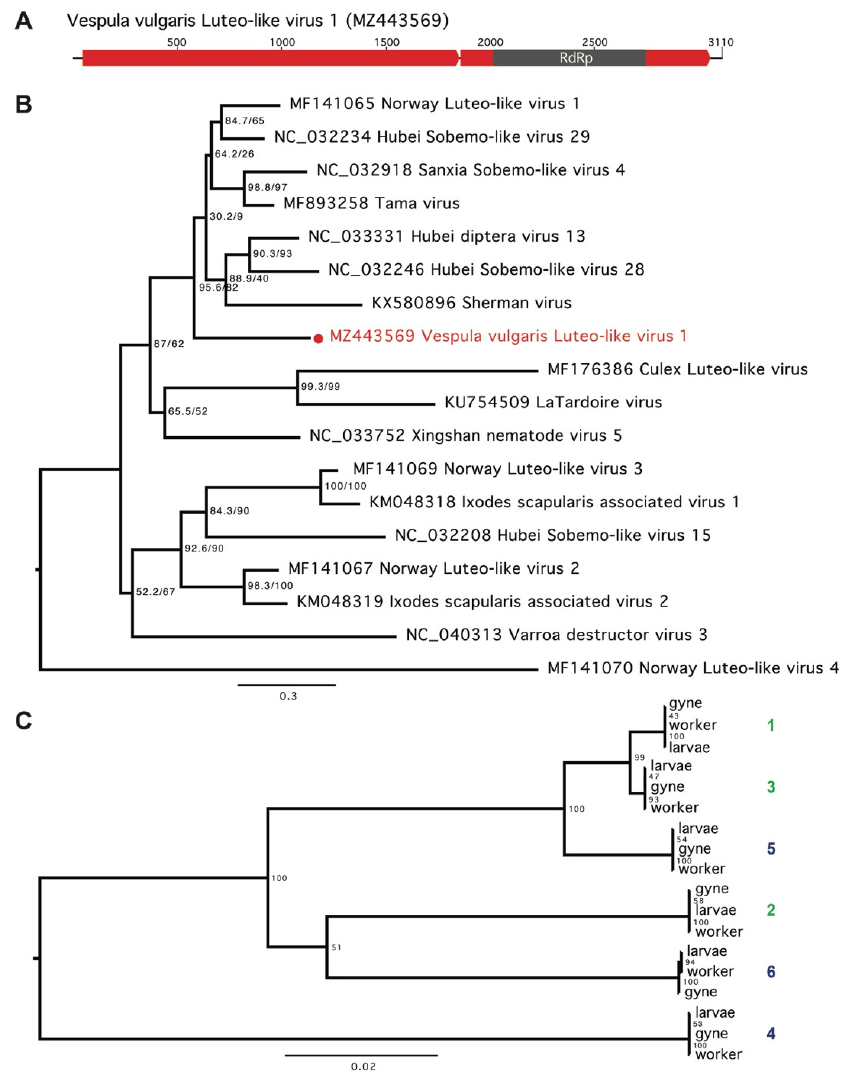
Figure 3. Vespula vulgaris Luteo-like virus 1. ( A ) The 3110-nucleotide genome contains two predicted ORFs (red). Conserved functional domains are indicated in grey. ( B ) Maximum likelihood phylogenetic tree of 18 selected Luteo/Sobemo viruses (GenBank accession numbers indicated), with Vespula vulgaris Luteo-like virus 1 indicated in red. After trimming, amino acid alignment length was 208 residues. The phylogenetic tree was generated in IQ-TREE, with the LG + I + G4 substitution model that had the optimal BIC score as determined by ModelFinder. Branch supports were estimated using ultrafast bootstrap approximation (UFBoot) using 1000 replicates. ( C ) Maximum likelihood phylogenetic tree comparing Vespula vulgaris Luteo-like virus 1 nucleotide sequences from all samples in six colonies (1–3: New Zealand; 4–6: Belgium). Sequences from each sample type (larvae, worker and gyne) form clades based on colony. The phylogenetic tree was generated in IQ-TREE, with the TIM2 + F + I substitution model that had the optimal BIC score. Branch supports were estimated using UFBoot with 1000